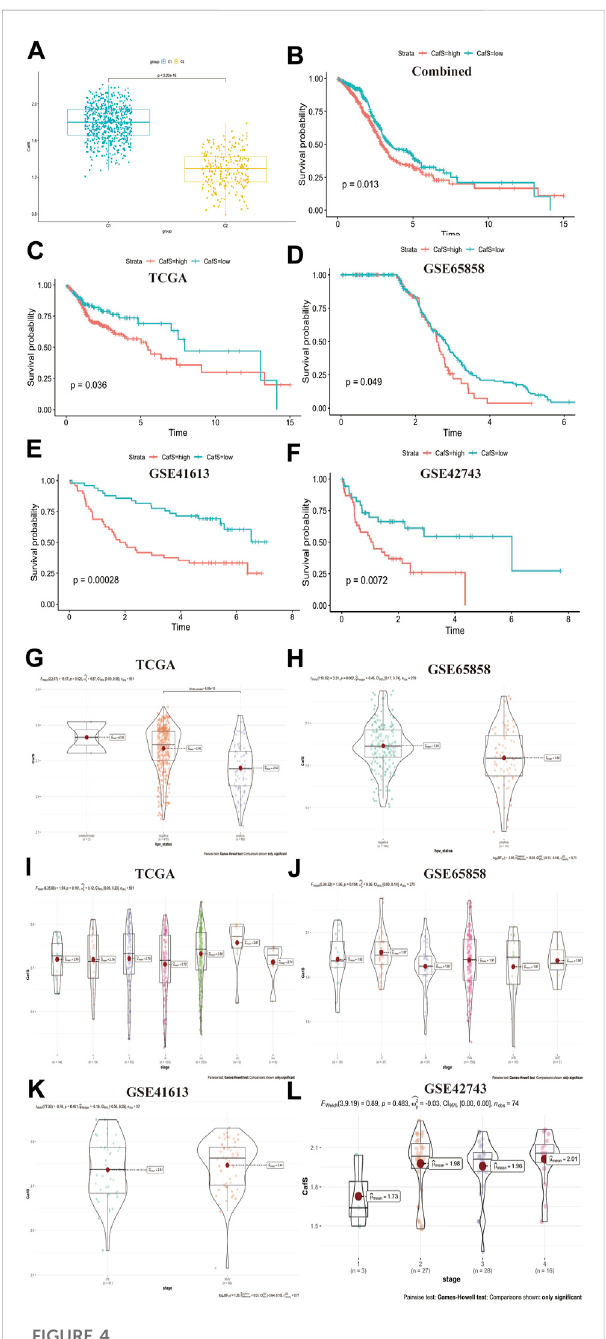
FIGURE 4 Construct a score system named CafS to evaluate 31 CAFs genes expression and classify HNSCC clinical characteristics (A) CafS in the groups of C1 and C2; combined database; p < 2.2e-16. (B – F) The Kaplan-Meier plot displays signi fi cant differences of survival time among the high-CafS and low-CafS groups in the Combined, TCGA, GSE65858,GSE41613,andGSE42743cohort,respectively.Highgroup was worse than low group, log rank p = 0.013, 0.036, 0.049, 0.00028, 0.0072. (G) CafSinTCGAcohortamongthegroupofHPVpositiveand HPV negative, p = 6e-10. (H) CafS in GSE65858 cohort among the group of HPV positive and HPV negative, p = 0.002. (I – L) CafS in TCGA, GSE65858, GSE41613, and external cohort GSE42743; among the group of stages; respectively, ( p = 0.101, 0.194, 0.451, 0.483).